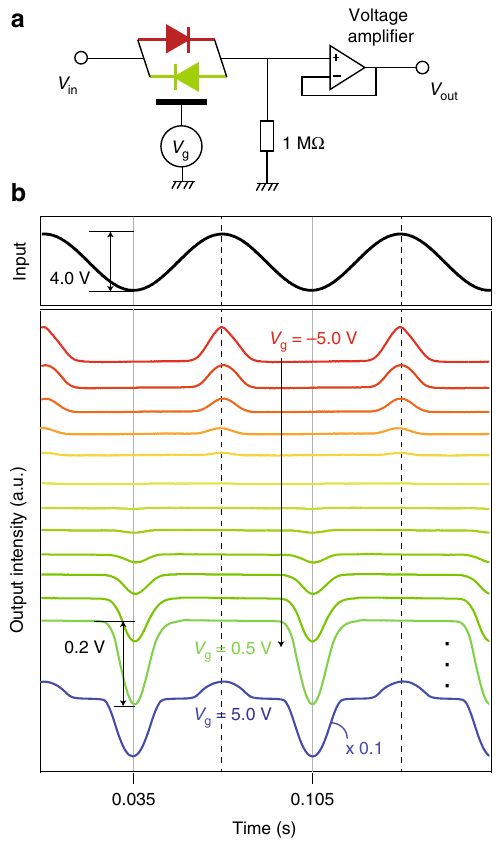
Fig. 5 Reversal recti fi cation of an analog harmonic signal in MoS 2 TC-FET. a Schematics of the gate-control recti fi er device placed in a measurement and biasing circuit. The MoS 2 TC-FET is symbolized as a polarity- switchable diode. b Input (harmonic signal ~13 Hz) and output waves of the gate-controlled diode. A π phase shift, together with multiple states of output level (e.g., pn diode, OFF, np diode, and full pass), in the recti fi ed output wave can be seen via gating. Each measured curve was averaged over 150 recorded